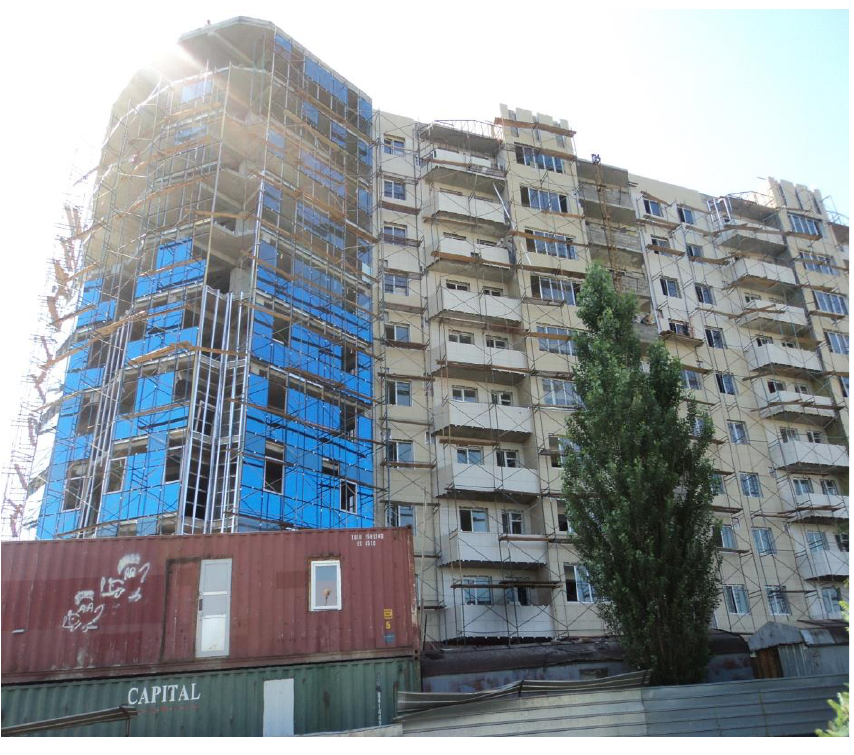
Figure A4. Reinforced Concrete.